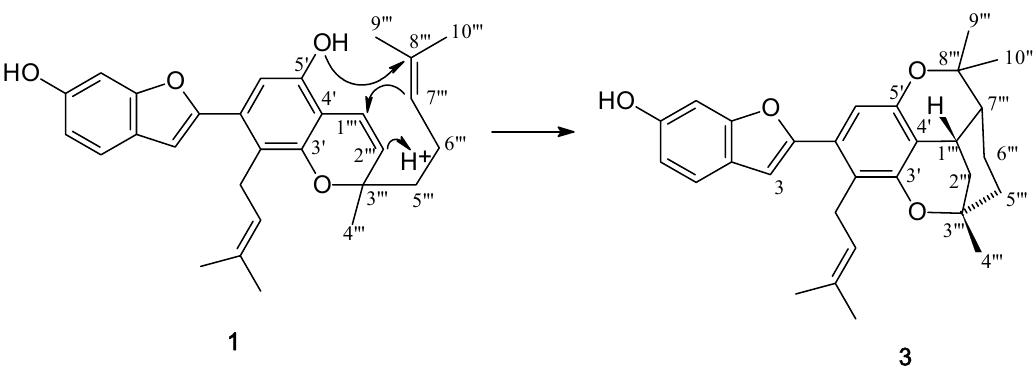
Figure 6. Possible biogenesis of 3 from 1